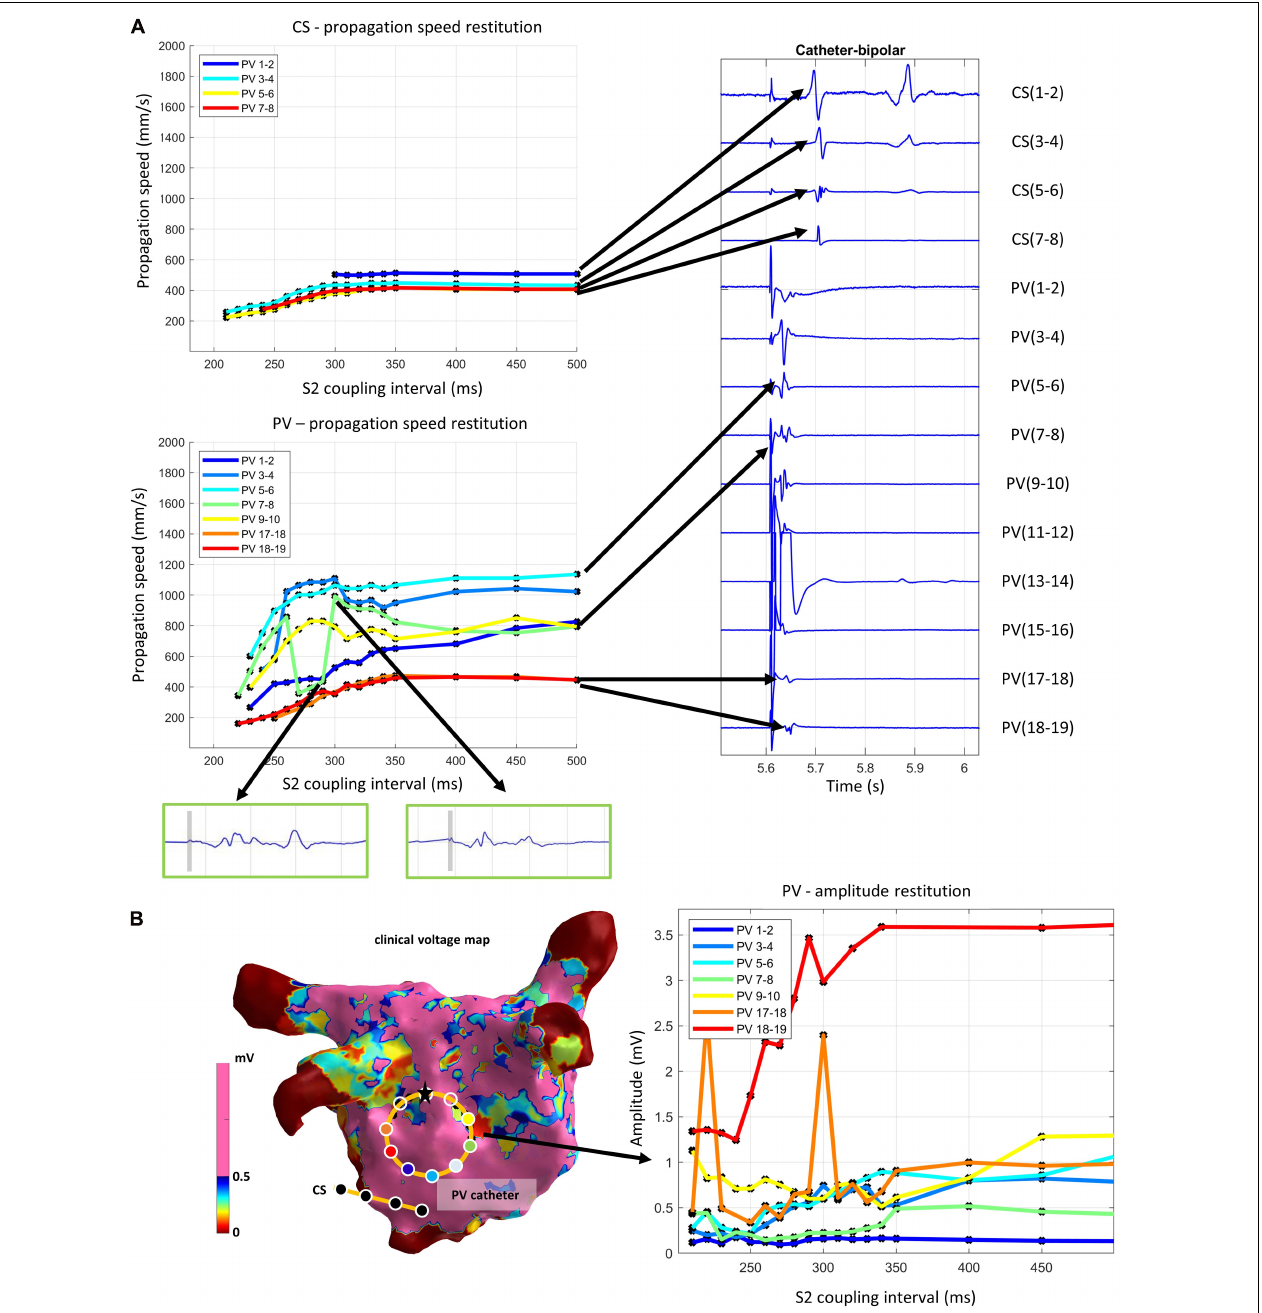
FIGURE 8 | (A) Exemplary output of the pipeline applied on a clinical measurement with stimulation from the circular catheter electrodes 13–14. Propagation speed restitution curves of each channel of the CS and the circular (PV) catheter (left) and the first corresponding S2 signal segment (right). Green boxes show excerpts of atrial activity signal after removal of the stimulation artifact (time segment marked in gray). (B) Voltage map (left) with circular catheter (PV) with white circles showing bipolar channel positions. Reconstructed amplitudes of circular catheter (stimulation from electrodes 13–14) with black dots representing data points (right). Lines are linearly interpolated in between. Line colors correspond to the color of the dot of the channel position on the voltage